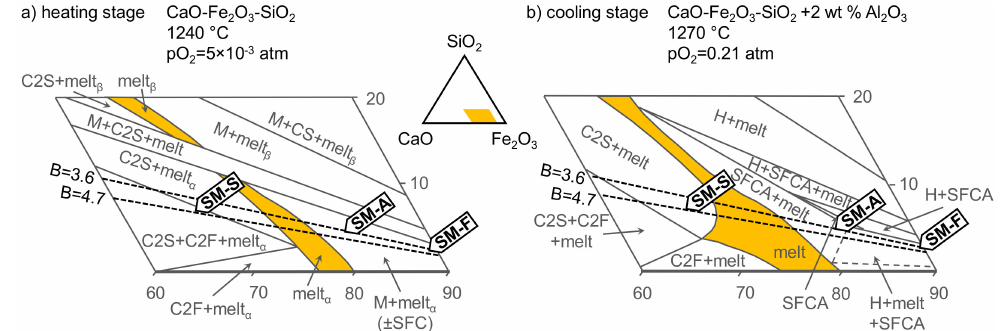
Figure 16. Adhering fines of SM-F, SM-A, and SM-S mixtures, according to chemical composition plotted into the CaO–Fe 2 O 3 –SiO 2 phase diagram’s isothermal sections. Section ( a ) CaO–Fe 2 O 3 –SiO 2 system at 1240 ◦ C and oxygen partial pressure pO 2 = 5 × 10 − 3 atm. Section ( b ) CaO–Fe 2 O 3 –SiO 2 system with 2 wt % Al 2 O 3 at 1270 ◦ C in air. Abbreviations denote: M: magnetite, H: hematite, SFC: silicoferrite of calcium (solid solution), C2F: dicalcium ferrite, C2S: Ca 2 SiO 4 , CS: CaSiO 3 . In the sections, dashed lines mark the useful basicity. Compositional range in wt %. Diagrams adapted from Pownceby and Clout